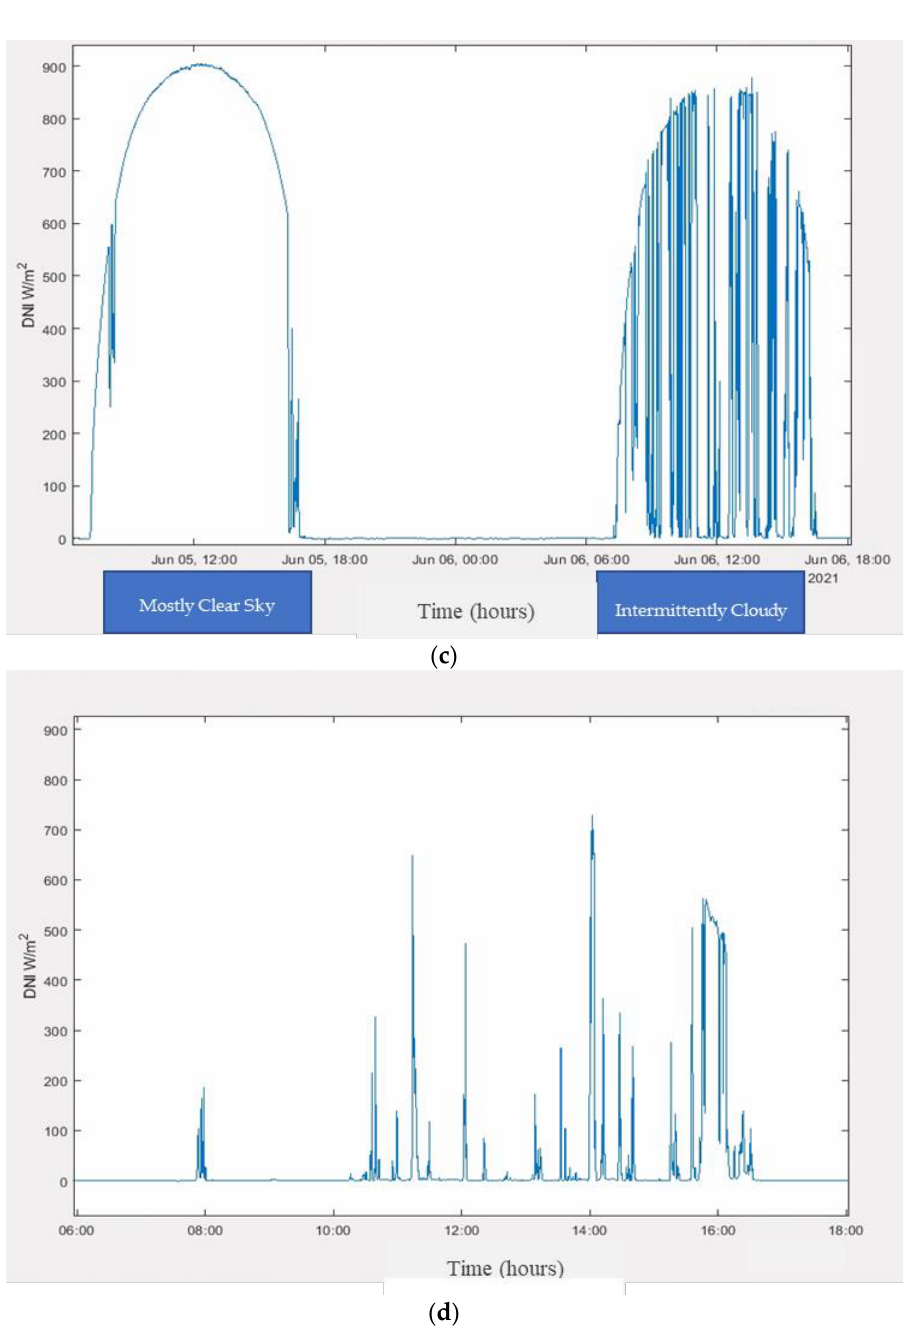
Figure 7. ( a ) A day in which all three classes are observed. ( b ) Simplified classification using mean, standard deviation, and shaded area where DNI values can be expected. ( c ) Example of a mostly clear sky (5 June) and an intermittently cloudy day (6 June). ( d ) Example of an overcast day (10 June).